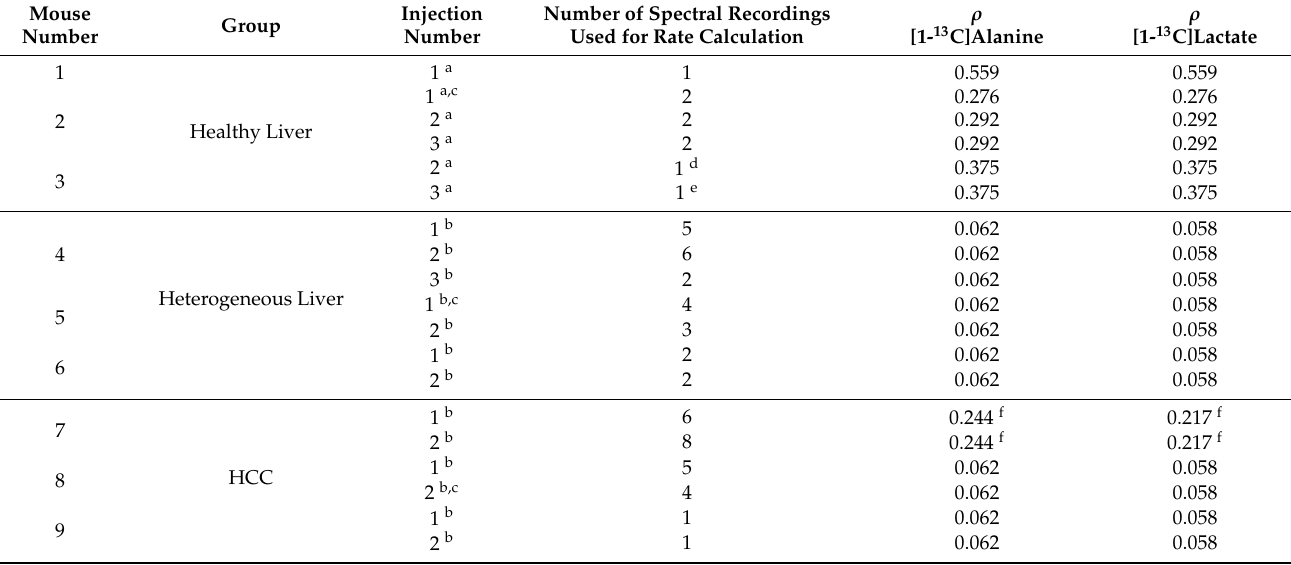
tissue taken from the HCC tumors in the livers of aged MDR2-KO mice (1.84 ± 0.46, n = 3). The LDH/ALT activities ratio of each group was found to be significantly different from the other two groups (Figure 3).